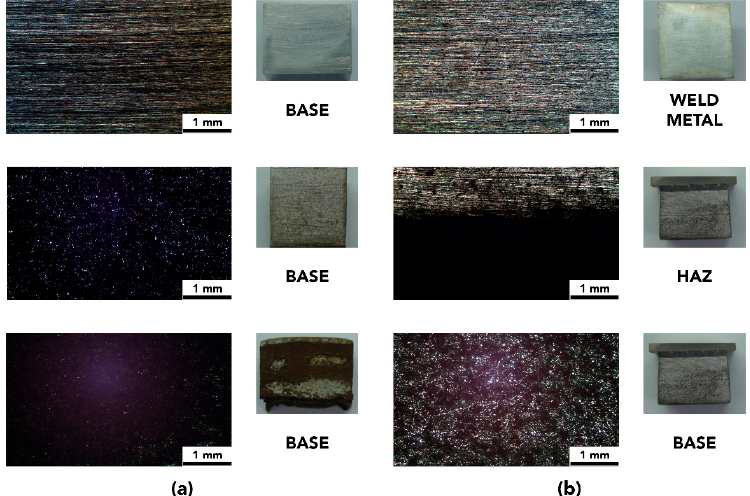
Figure 15. The weight loss corrosion testing results: ( a ) A36 plate (W1); ( b ) 309L cladding on A36 plate (W2).